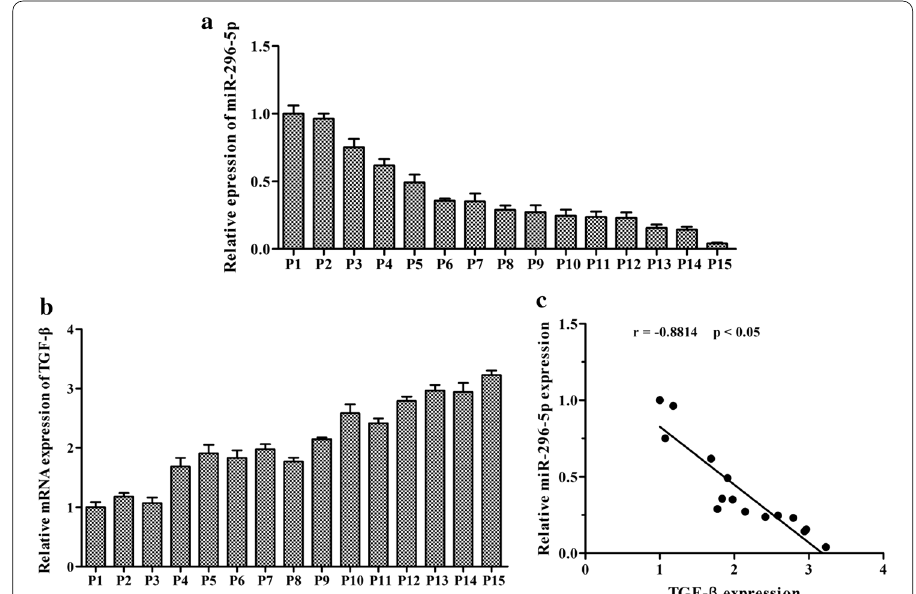
Fig. 6 Clinical relevance of miR-296-5p with TGF-β in NPC tissues. a MiR-296-5p expression in human NPC tissues. b TGF-β expression in human NPC tissues. c The correlations between miR-296-5p levels and TGF-β expression in NPC tissues were calculated with Pearson’s correlation tests. *p <